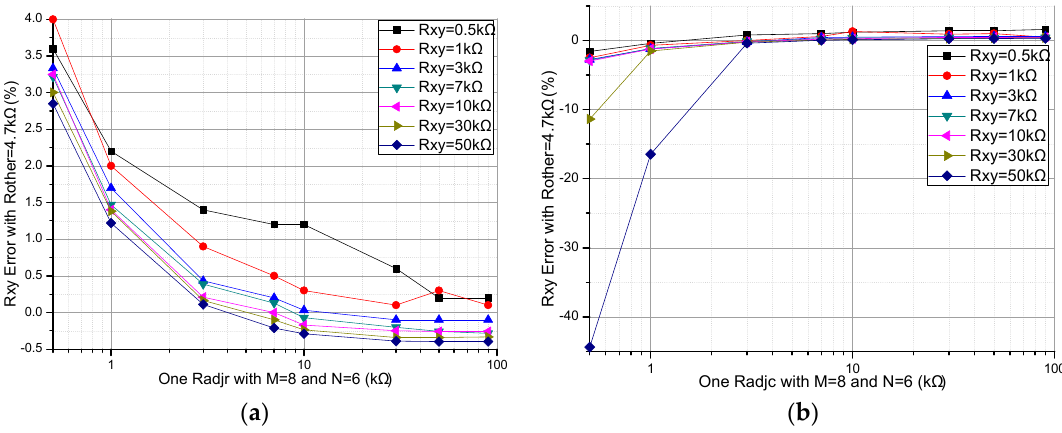
Figure 11. Results of one adjacent element on the EBT’s errors of the improved circuit: ( a ) one R adjr ; and ( b ) one R adjc .